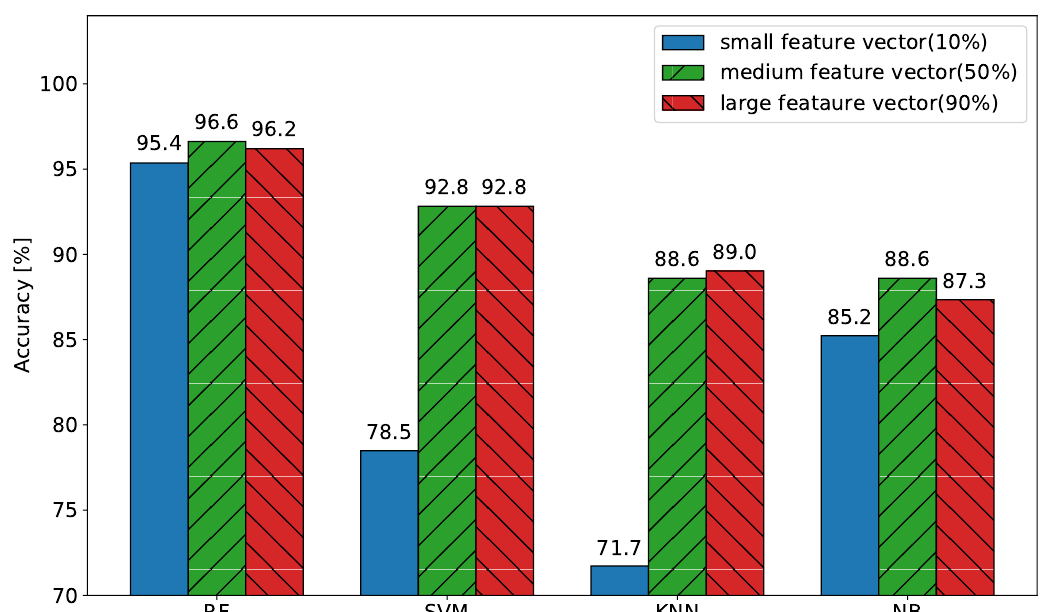
Figure 15. Accuracy scores of all 16 models trained by the ring data set of the watch session. Each model type was trained with three different feature vector sizes and tested against the held-back test data